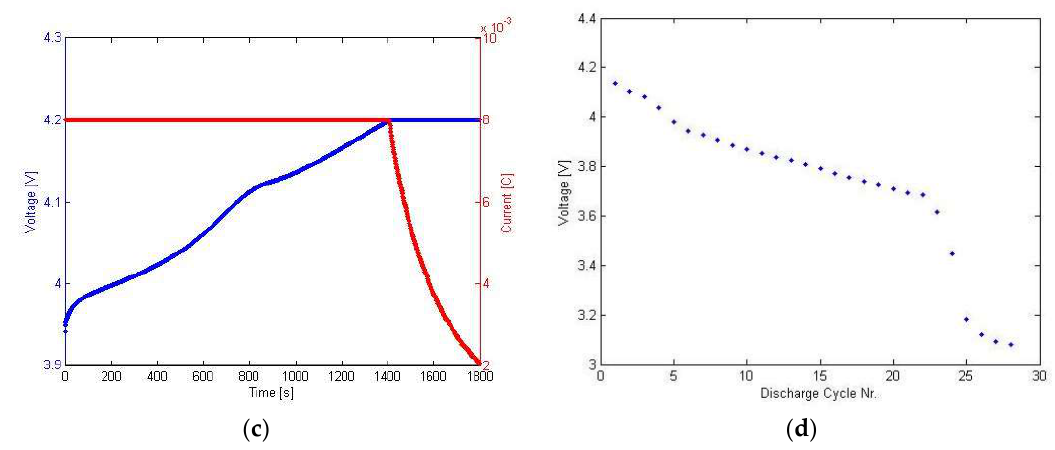
Figure 4. Open circuit voltage and state-of-charge (OCV–SoC) results: ( a ) Recharging of the battery under constant current and constant voltage conditions (CCCV); ( b ) charging terminal voltage; ( c ) charging of the battery under CCCV; ( d ) discharging terminal voltages.